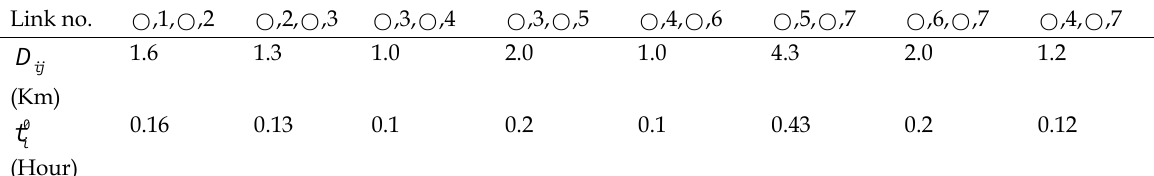
Table 3. Parameters for travel cost of the above corridor network Link no.